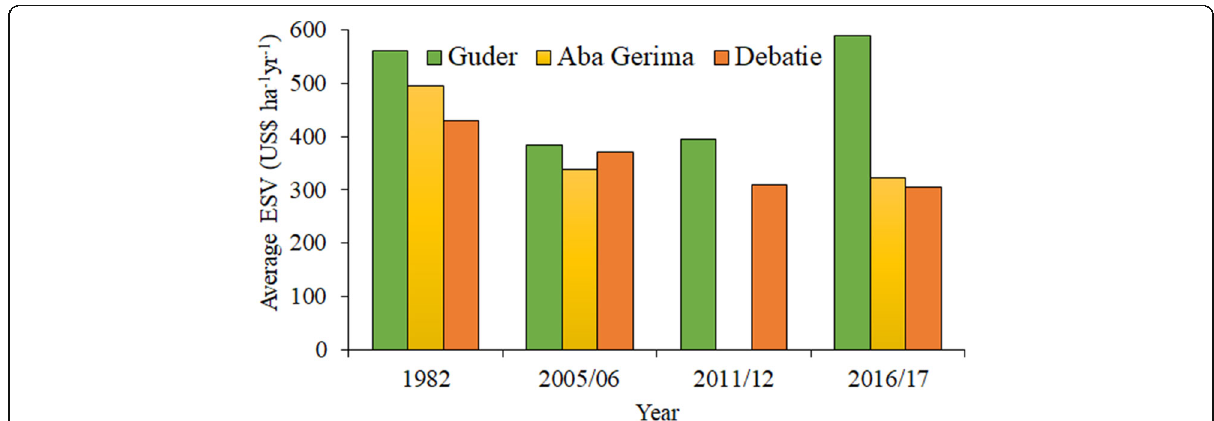
Fig. 3 Average ecosystem service values (ESV) for Guder, Aba Gerima, and Debatie watersheds, Ethiopia, from 1982 to